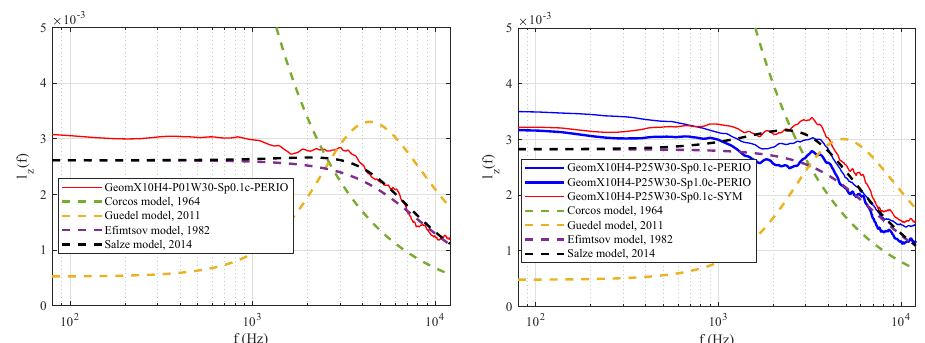
Figure 6. Spanwise correlation length, l z , for different spanwise boundary conditions ( left ), and different spanwise extents ( right ), in comparison with empirical